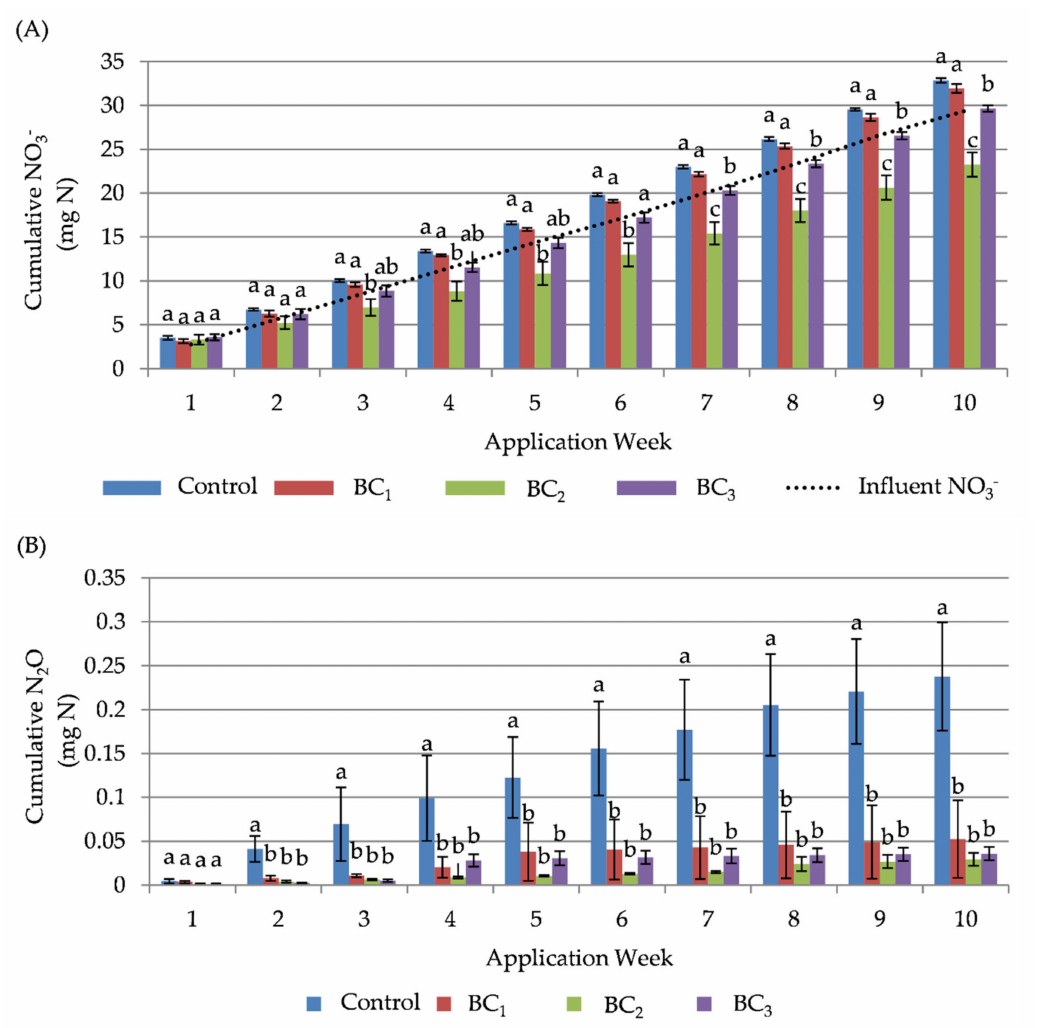
Figure 5. Cumulative ( A ) NO 3 − -N leached and ( B ) N 2 O emitted from columns receiving NO 3 − -N applications. Di ff erent letters signify significant di ff erence ( p < 0.05) between control and biochar treatments. Error bars represent standard deviation between treatment